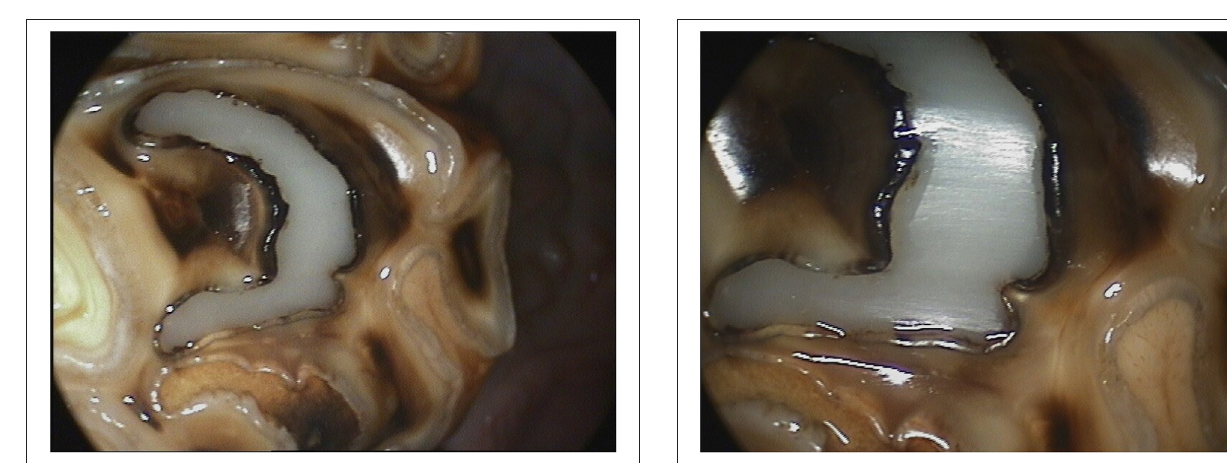
FIGURE 6 | Close up oroscopic images of a Triadan 109 tooth 2 years post-restoration (same tooth as Figure 5 ). Attritional wear lines can be seen through the restorative material.